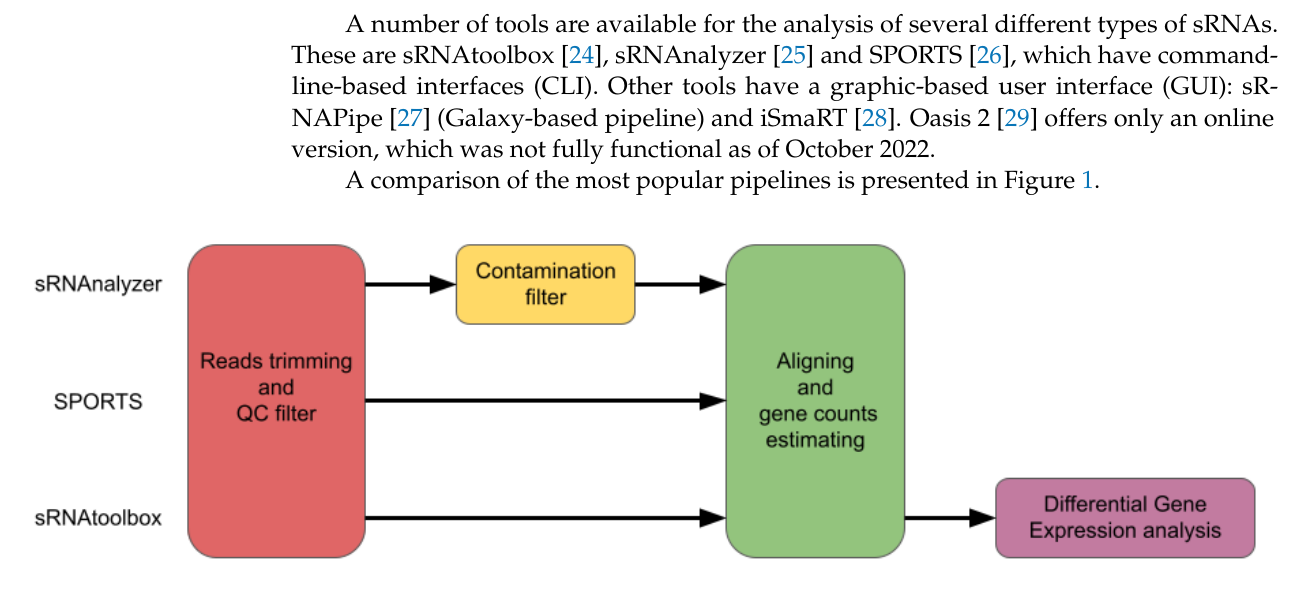
Figure 1. Pipeline comparison for sRNAnalyzer, SPORTS and